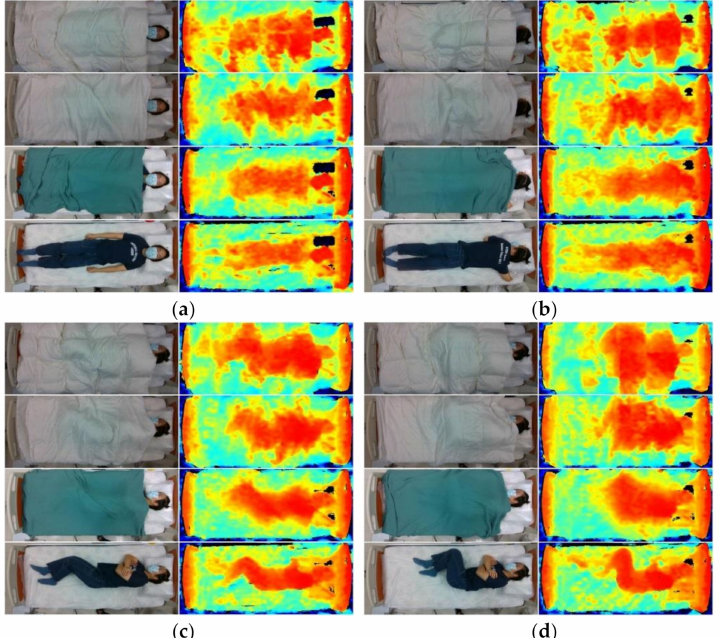
Figure 1. RGB (left column) and infrared (right column) images of typical participant under thick (first row), medium (second row), thin (third row), and control (fourth row) blanket conditions in ( a ) supine, ( b ) prone (head left), ( c ) log (right), and ( d ) fetal (right)